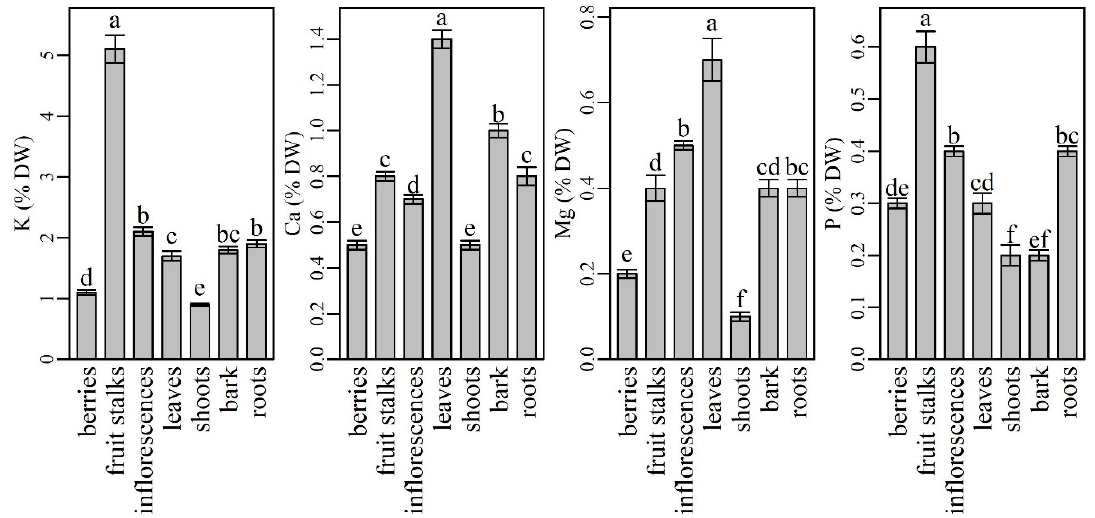
Figure 1. The content of macroelements in different parts of elderberry plants. Means labelled with the same letter are not significantly different (Tukey, p ≤ 0.05).